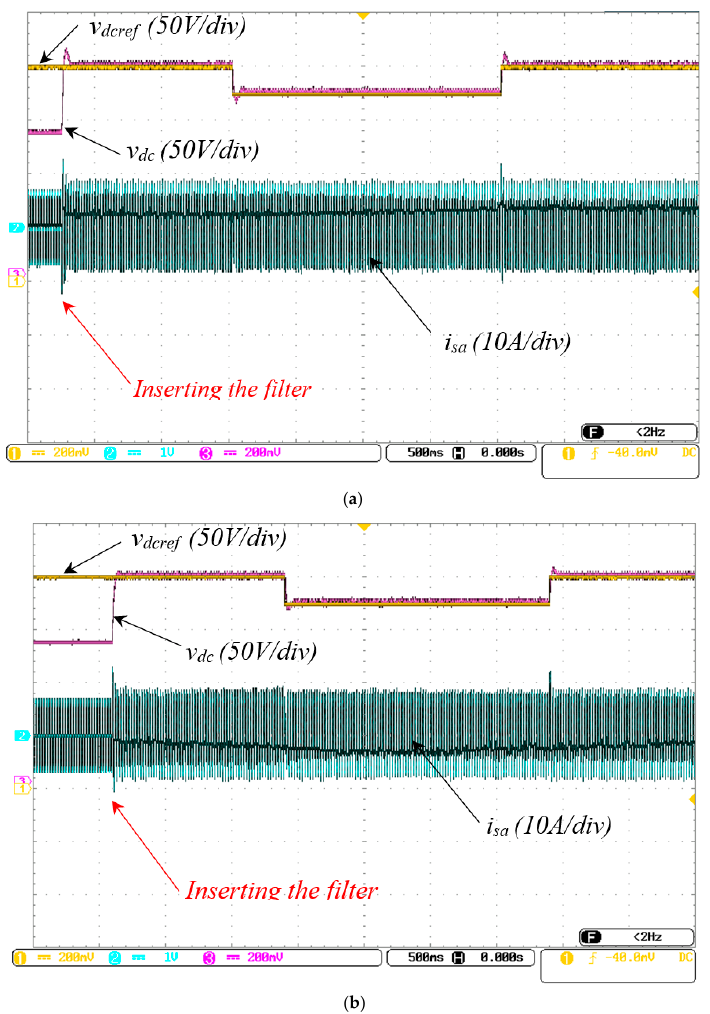
Figure 9. Response of DC bus voltage under double step change of reference voltage based on conventional ( a ) and optimized ( b ) anti-windup PI controller.